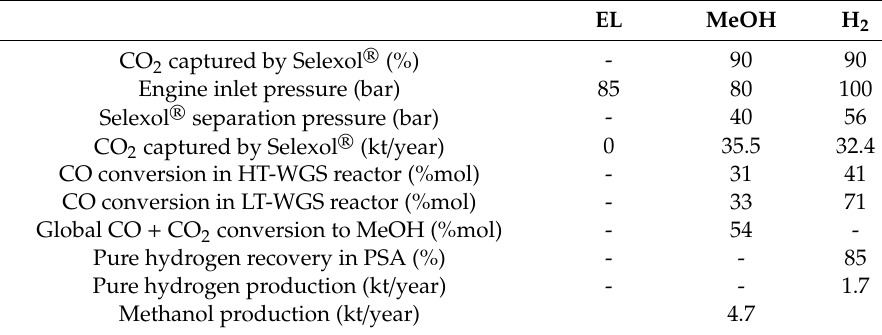
Table 5. Process simulation main